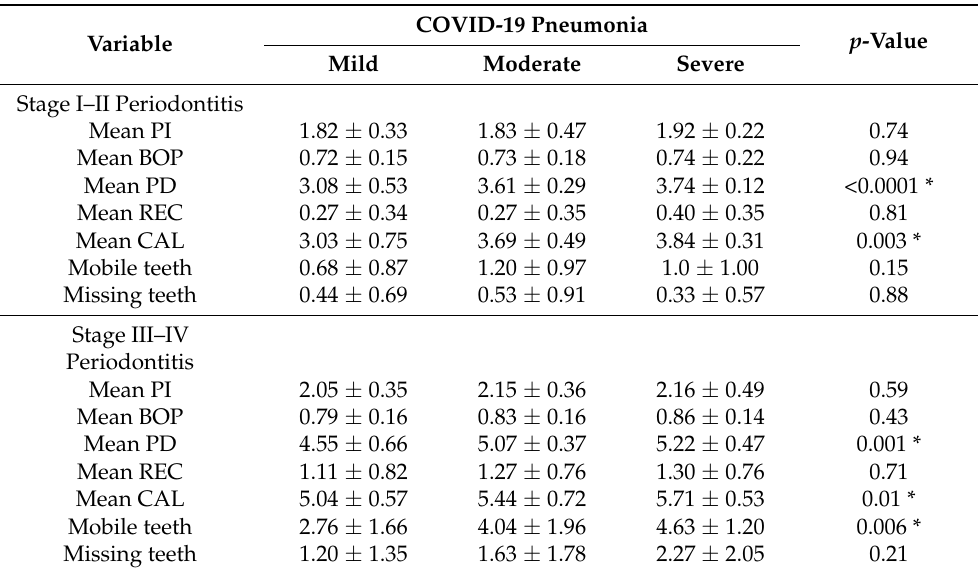
Table 3. Comparison of periodontal parameters of periodontitis patients between the three COVID-19 groups.